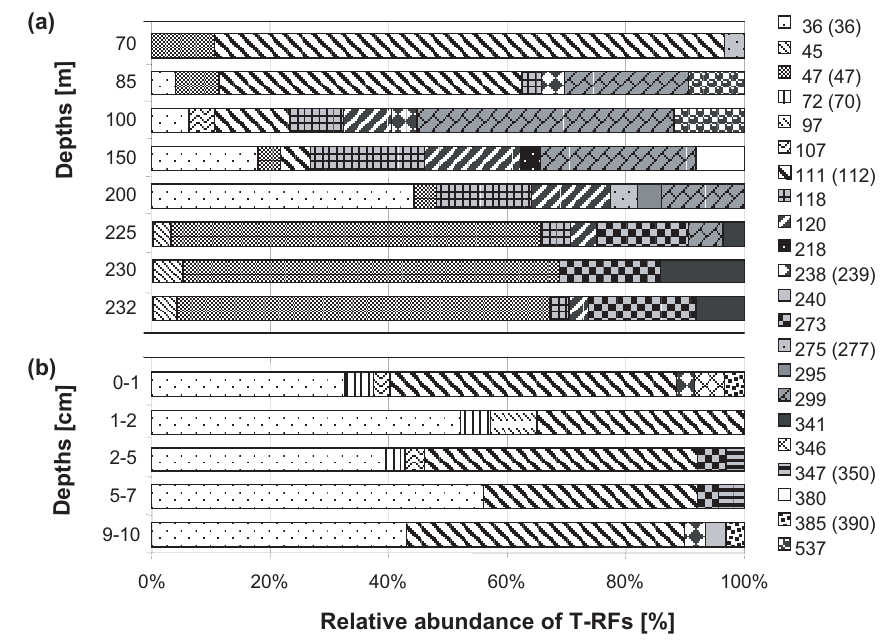
Fig. 3. Relative abundance of terminal restriction fragments of nirS amplicons. Numbers indicate the size of the fragment in base pairs after T-RFLP analysis, numbers in parentheses indicate size of the fragment after in silico analysis; (a) samples from the water column at the Gotland Deep; (b) , samples from a sediment core taken in the